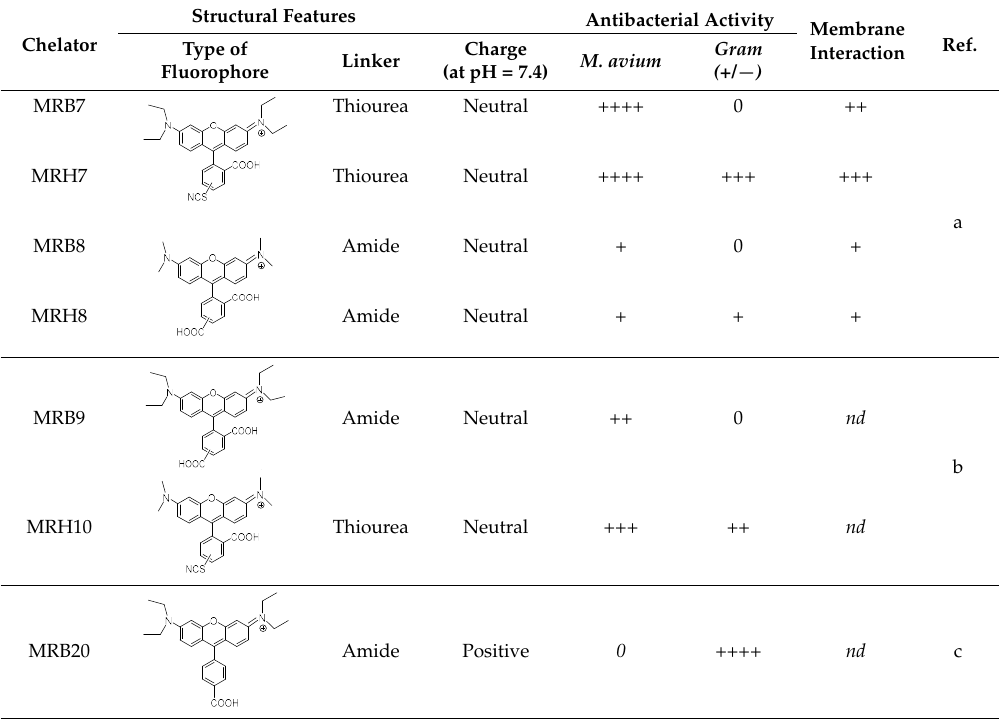
Table 1. Summary of the antibacterial activity, structural features and membrane interaction of the fluorescent chelators. (0–no effect; +–low; ++ moderate; +++–high; ++++ very high effect; nd –not determined).